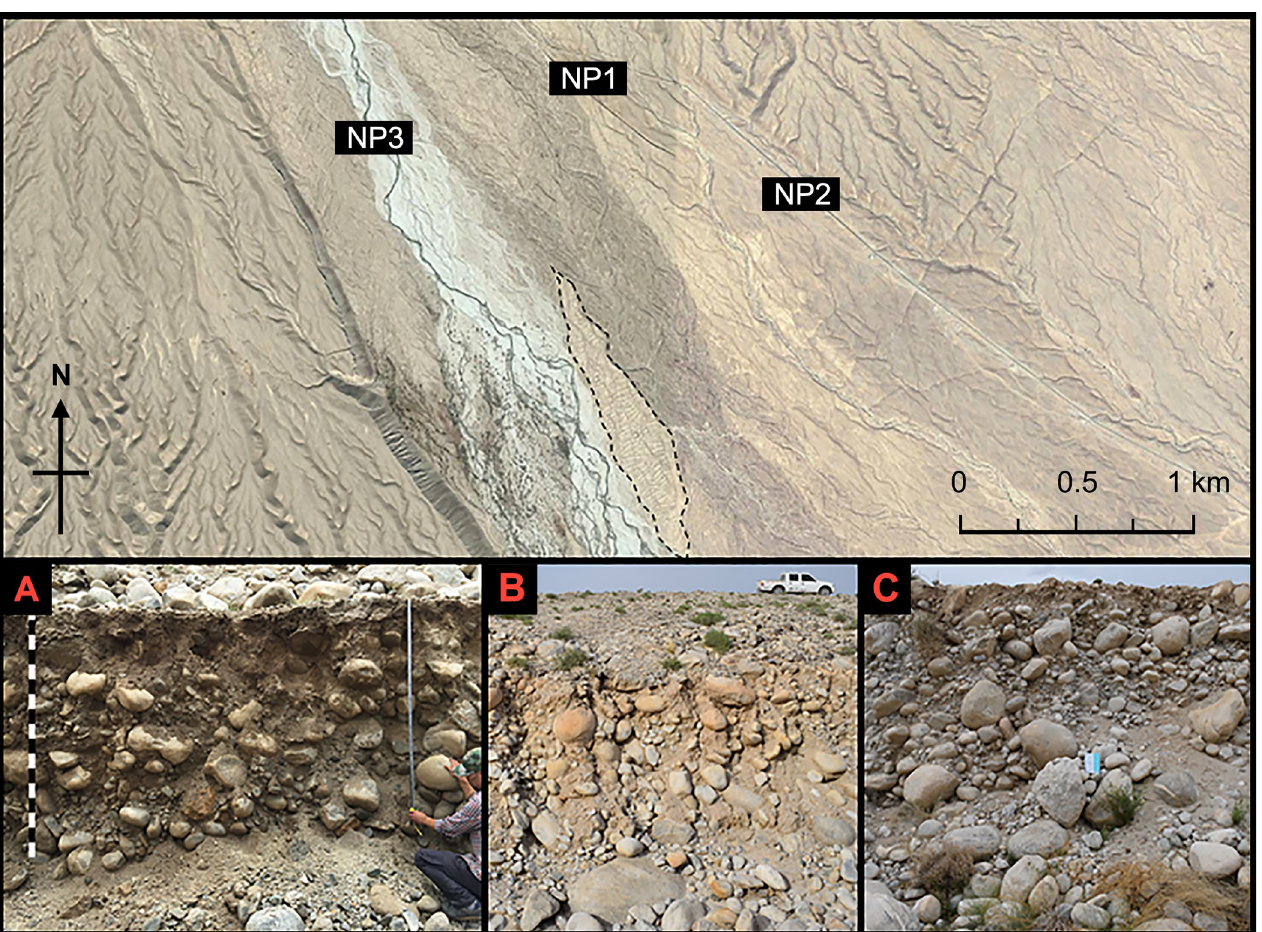
Fig 4. The three natural profiles examined in this study. (A) Natural profile 1. (B) Natural profile 2. (C) Natural profile